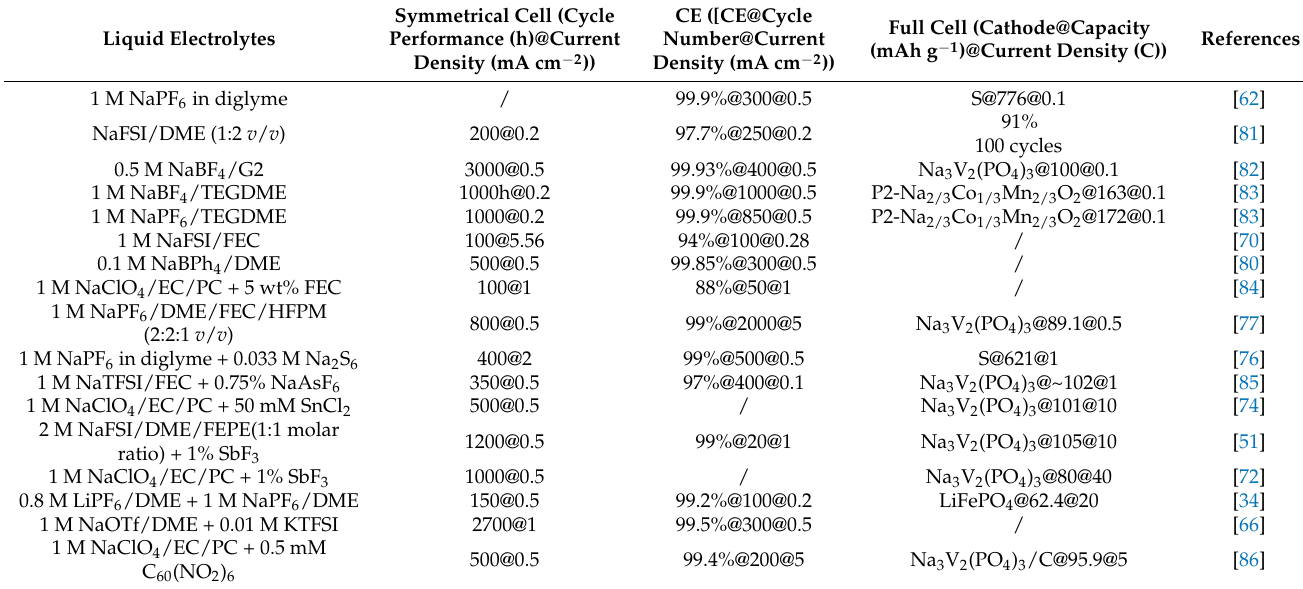
Table 1. Electrochemical properties of different liquid electrolytes in